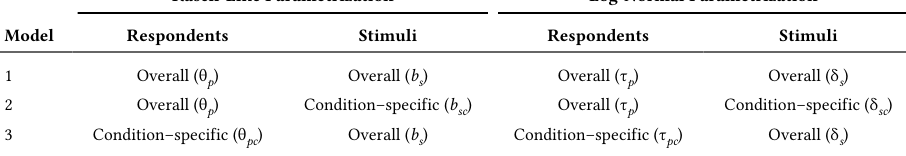
Rasch-Like and Log-Normal